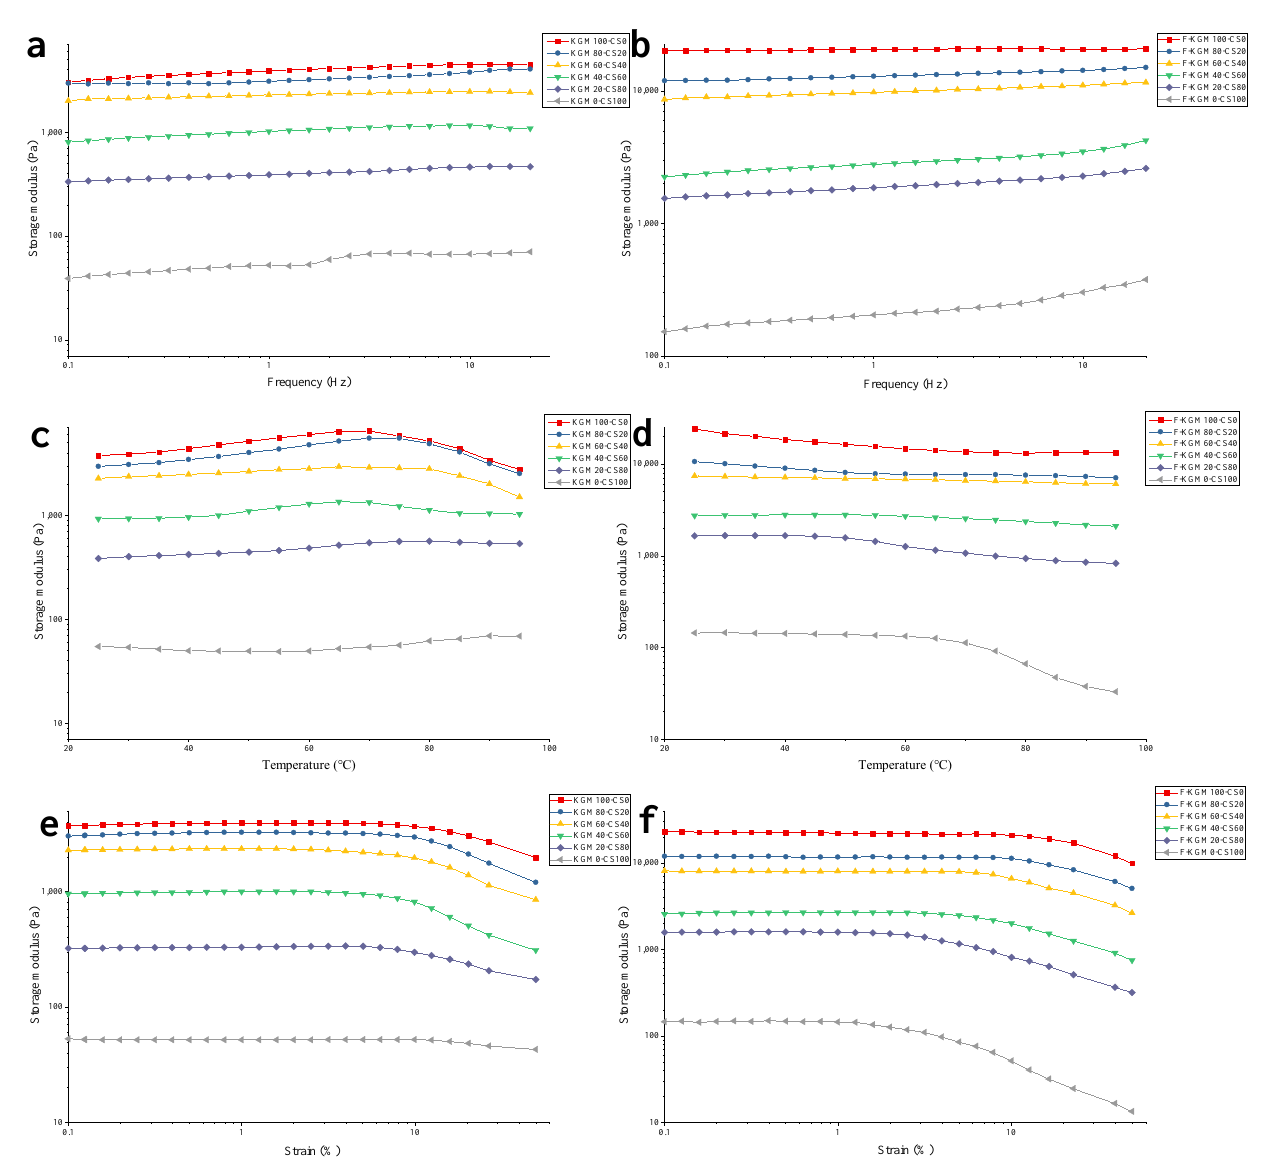
Figure 1. Rheological curves of the composite gels with different konjac glucomannan (KGM)/corn starch (CS) ratios. Frequency sweep of KGM–CS ( a ) and freeze–thawed KGM–CS (F–KGM–CS) ( b )